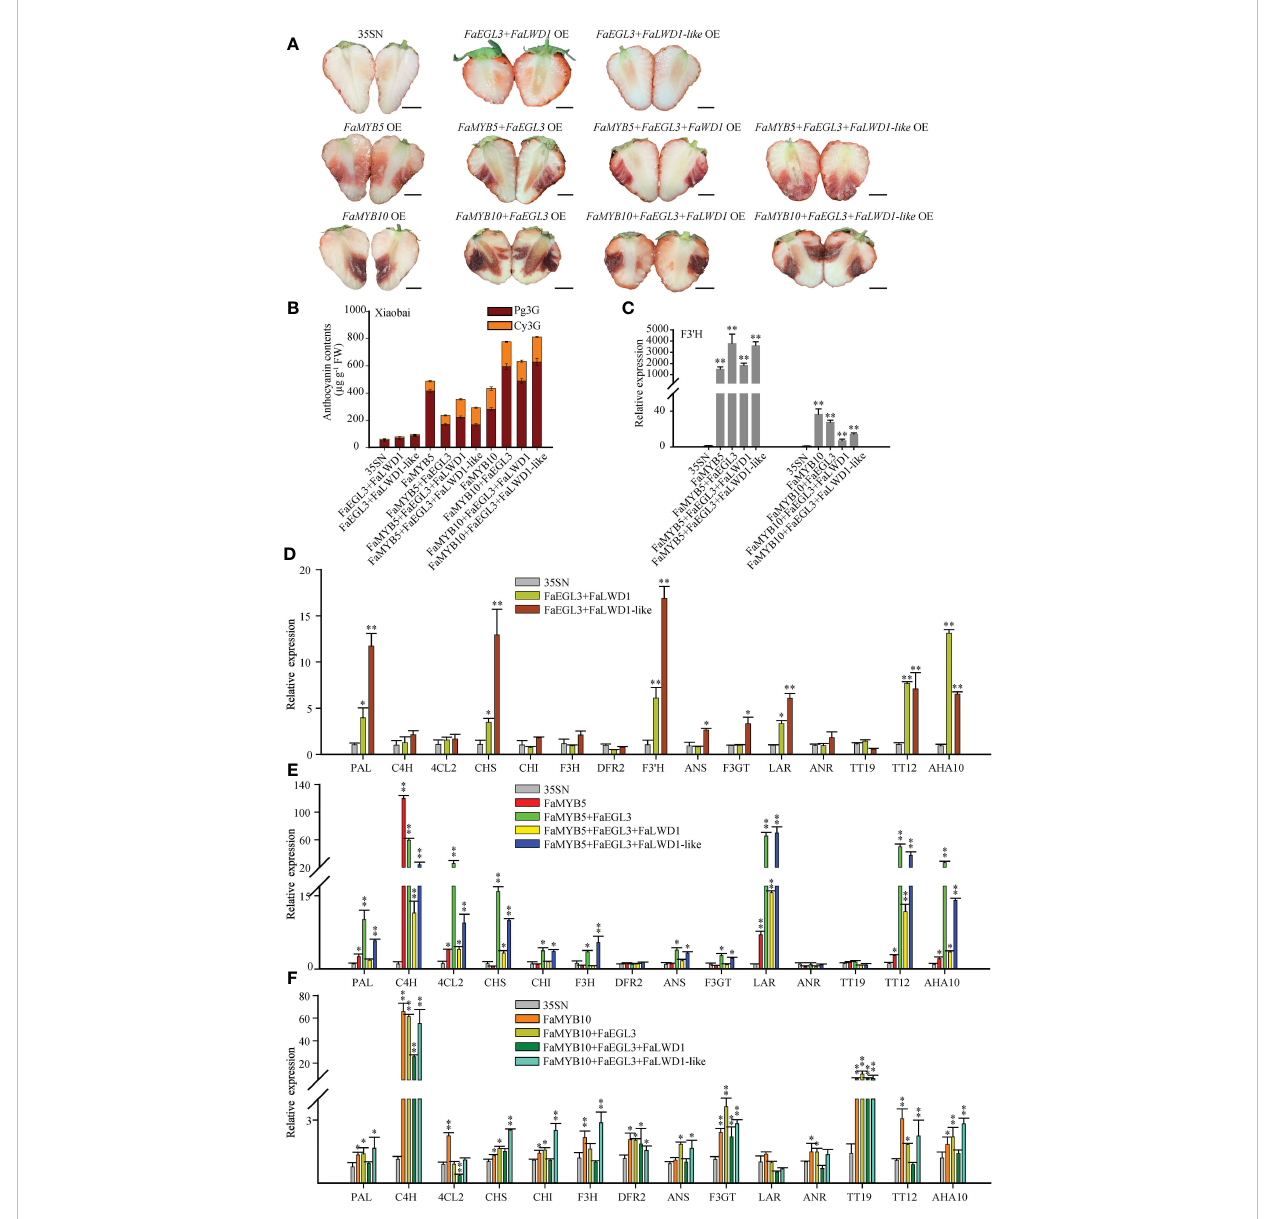
FIGURE 4 Effects of FaMYB5/10 dominated MBW complexes on fl avonoid biosynthesis in strawberries. (A) The phenotype of co-overexpressed TFs in ‘ Xiaobai ’ . 35SN (empty vector) was as control. Scale bars represent 10 mm. (B) Analysis of Cy3G and Pg3G by HPLC in ‘ Xiaobai ’ . (C-F) qRT-PCR analysis of relative expression levels of key structural genes and transport factors in the fl avonoid biosynthesis pathway. Error bars are SEs for three replicates, statistical signi fi cance was determined by Student ’ s t-test (**, P < 0.01; *, P <